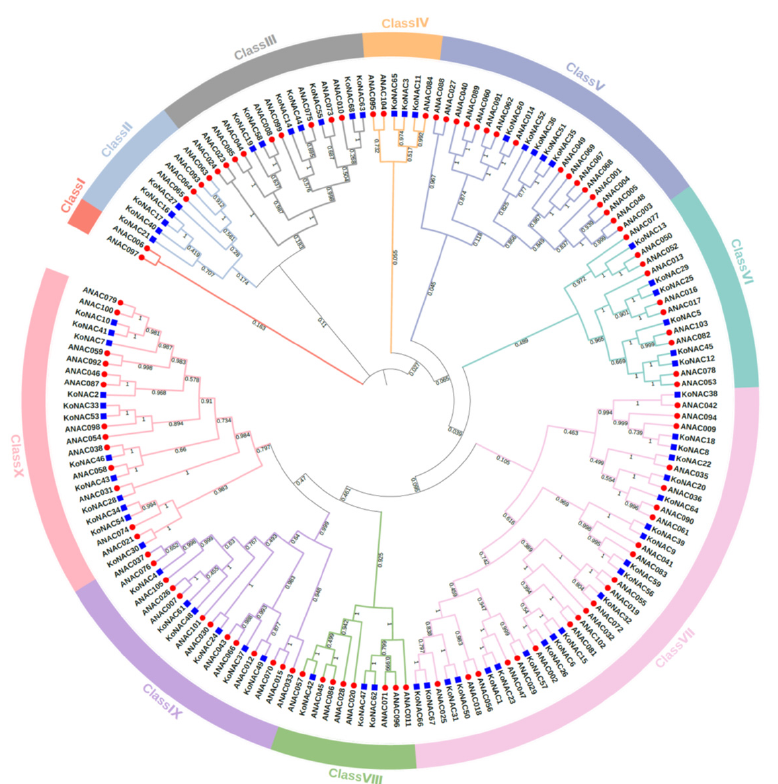
Figure 2. Phylogenetic analysis of the NAC proteins from K. obovata and A. thaliana . The unrooted tree was constructed by MEGA 7.0 based on the neighbor-joining (NJ) method with 1000 bootstrap replications. The NAC proteins of K. obovata ( Ko NAC) in blue squares, and A. thaliana ( At NAC) in red circles were classified into ten classes represented with different colors.